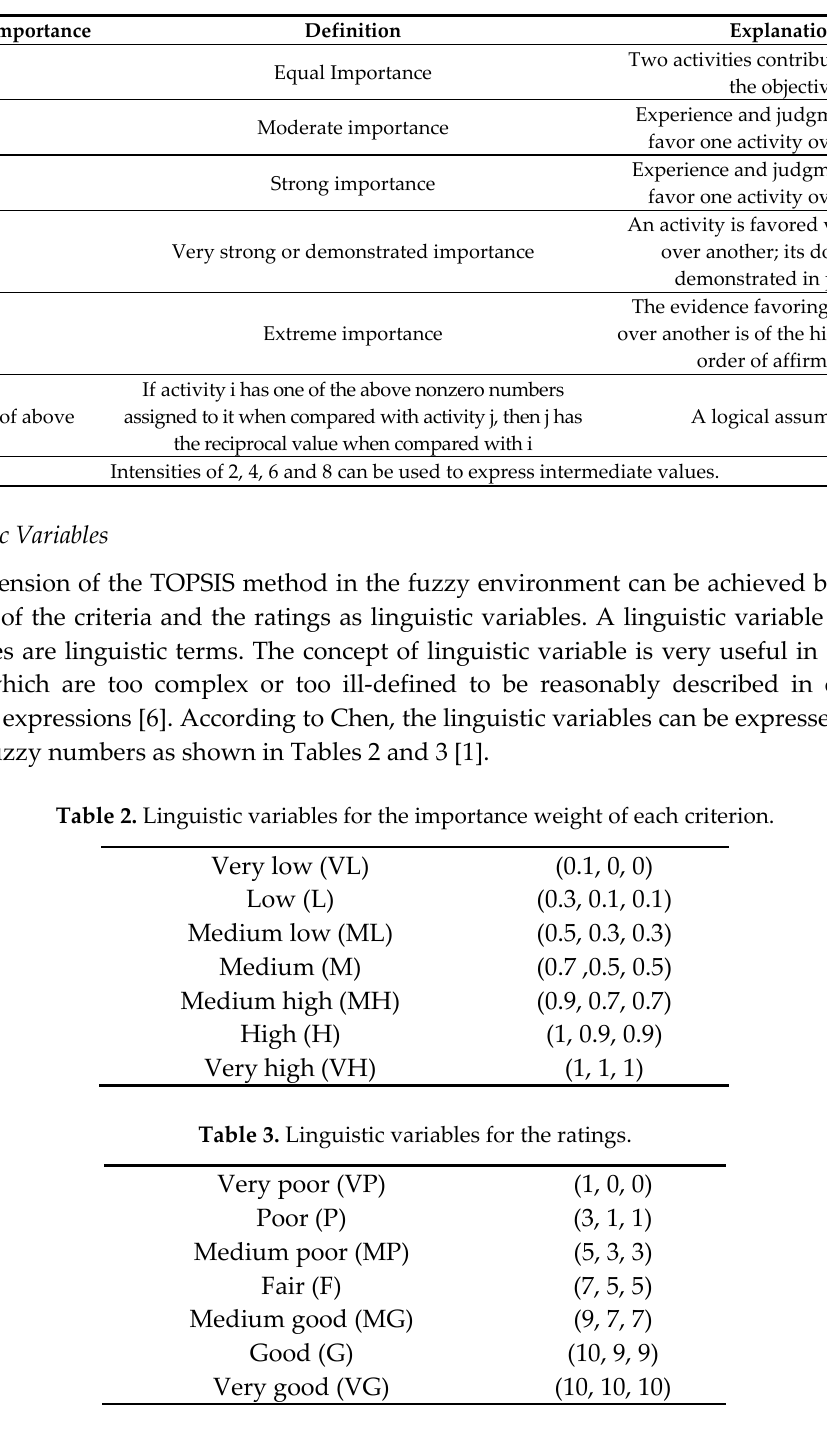
Table 1. Fundamental Scale of Absolute Numbers.